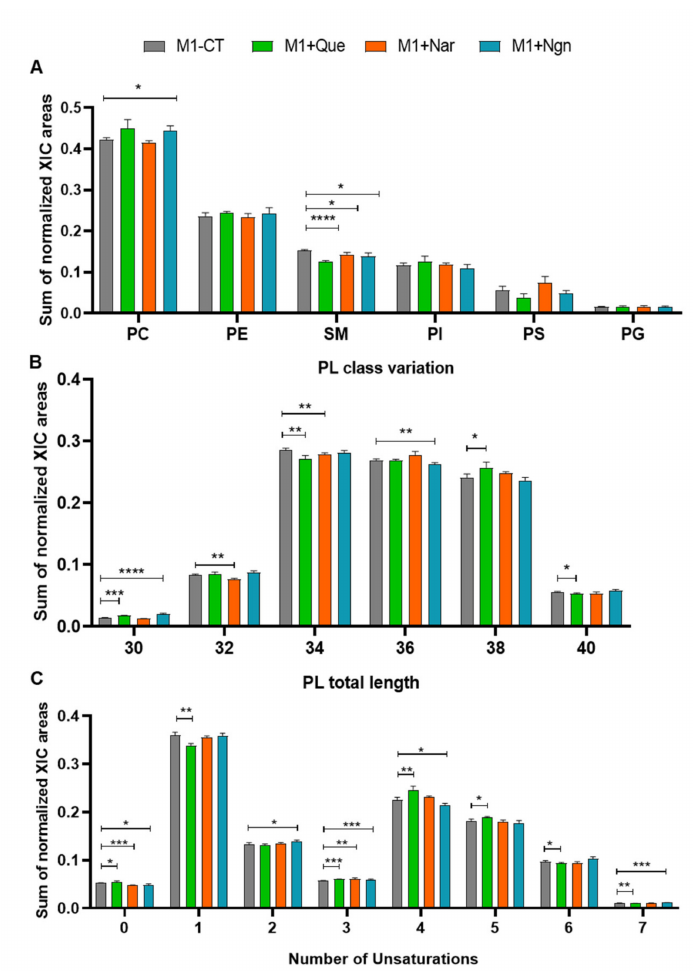
Figure 3. Phospholipidome of proinflammatory THP-1-derived macrophage-like cells, incubated for 24 h in flavonoid-free medium (M1-Ct) or treated with quercetin (M1 + Que), naringin (M1 + Nar) or naringenin (M1 + Ngn): ( A ) Relative abundances of main phospholipid (PL) classes (PC, phosphatidylcholine; PE, phosphatidylethanolamine; SM, sphingomyelin; PI, phosphatidylinositol; PS, phosphatidylserine; PG, phosphatidylglycerol). The PC class comprises diacyl-, alkyl / alkenyl-acyl and lysophosphatidylcholines, and the PE class comprises diacyl, alkyl / alkenyl-acyl- and lysophosphatidylethanolamines. ( B ) Number of carbons in PL fatty acyl chains. ( C ) Number of double bonds in PL fatty acyl chains. * p < 0.05, ** p < 0.01, *** p < 0.001, **** p <